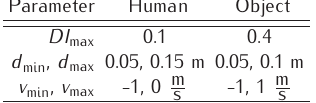
Figure 10. (a) 3D view of the generated path for a CRS-F3 arm and (b) its top view. The solid black lines depicts the manipulator links at start and goal points, respectively.